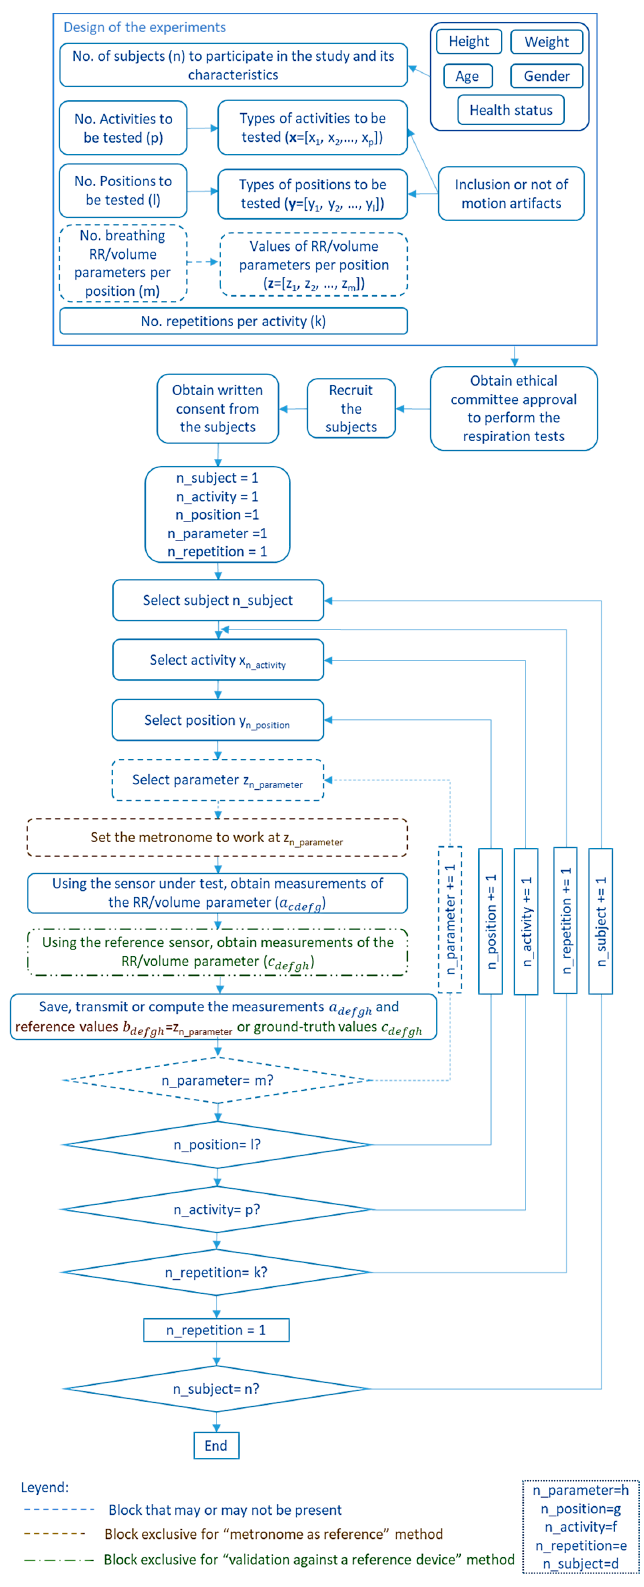
Figure 27. Flow chart for the validation of a respiration sensor using the methods “metronome as reference” and “validation against a reference device”.